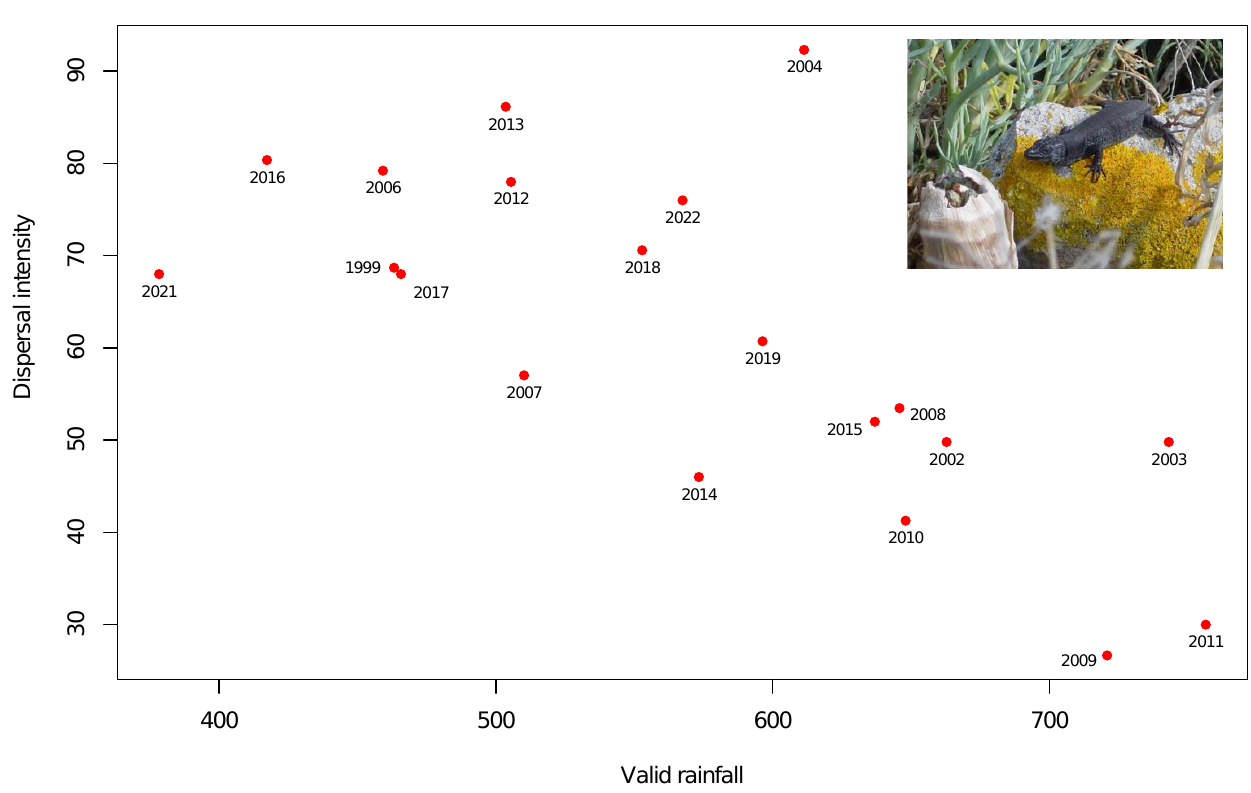
Figure 7. Annual dispersal intensity (red lines, right y -axis) and annual density of Helicodiceros muscivorus (green bars, individuals/hectare ± SE, left y -axis) in high-density area. The extraordinary increase in plant density from 2003 is clearly evident.